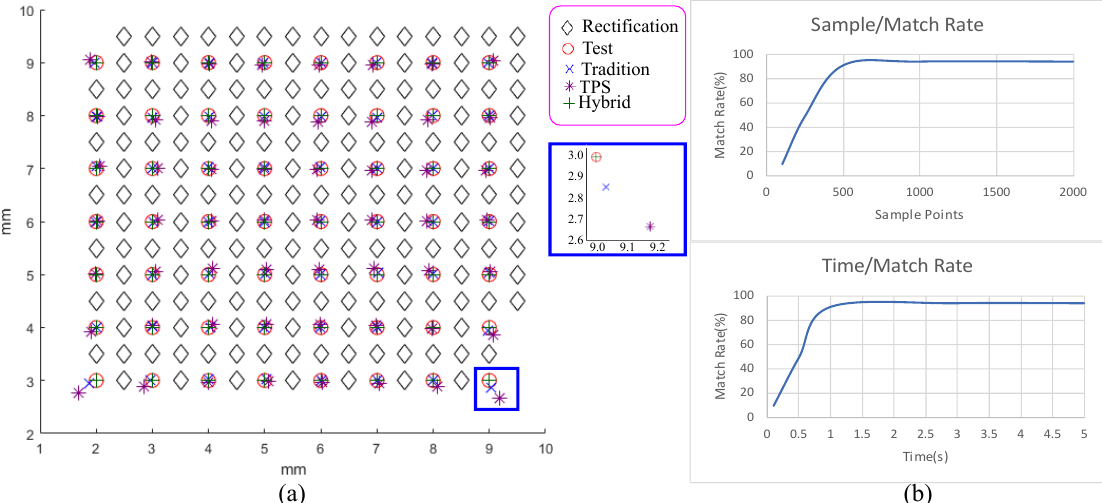
Figure 4. ( a ) This shows the rectification results of traditional radial and tangential distortion removal (blue crosses), thin-plate spline (TPS) interpolation (purple stars), hybrid of both (green pluses), and ground truth (red circles). Their averaging errors are as 6.96 × 10 − 2 , 2.58 × 10 − 2 , and 1.52 × 10 − 2 mm, and their maximal deviations are 3.95 × 10 − 1 , 1.44 × 10 − 1 , and 7.67 × 10 − 2 mm. ( b ) This shows the relation between the alignment success rate and the number of samples (top) and computation time